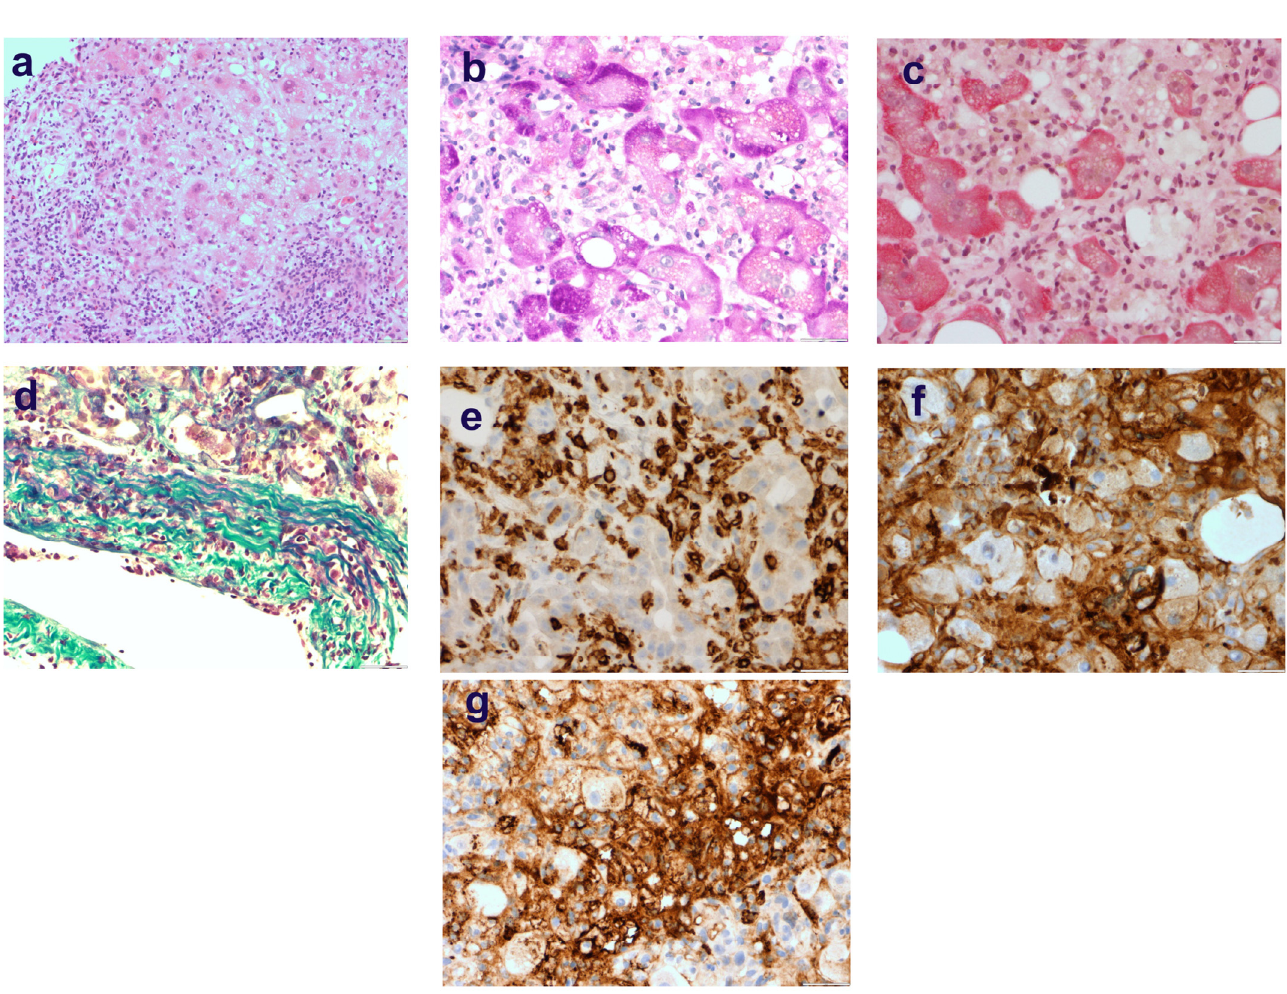
Figure A2. Pictures ( a – g ): Histopathological images of the patient’s liver. ( a ) Hematoxylin and eosin stain: Extensive mixed-cells infiltration bundant mixed-cells infiltration with a predominance of lymphocytes and plasma cells in the portabiliary area, periportal areas and intrahepatic trabecula. ( b ) Selective stain: paS (+). ( c ) Selective stain: glycogen (+). ( d ) Selective stain: Masson’s trichrome (+). ( e ) Immunohistochemical reaction LCA (+) in the inflammatory infiltrates. ( f ) Immunohistochemical reaction IgG (+). ( g ) Immunohistochemical reaction IgM (+).